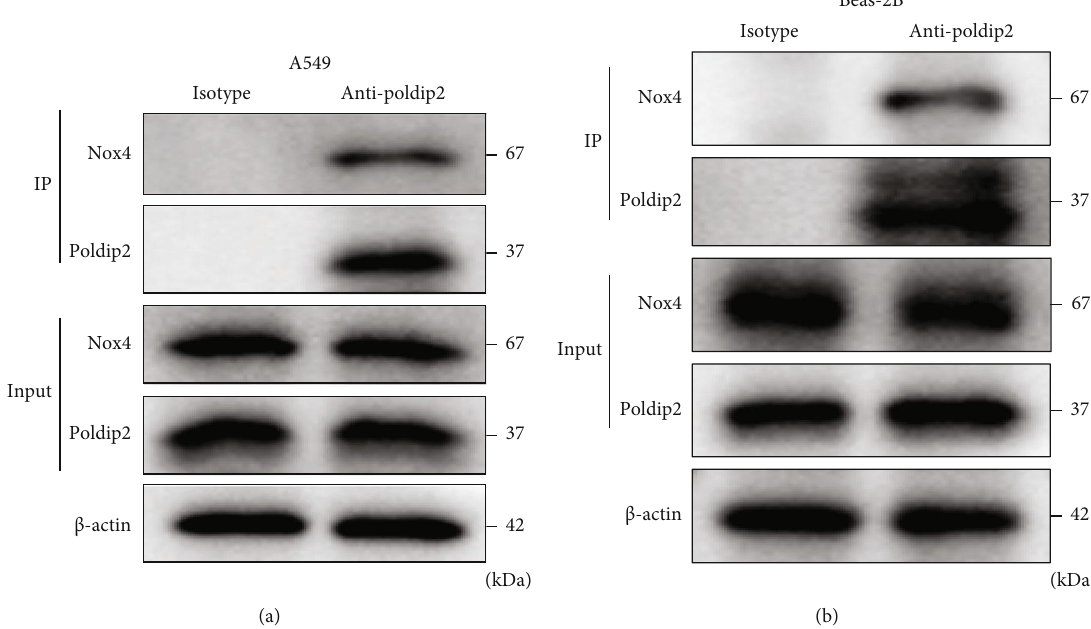
Figure 2: Poldip2 interacted with Nox4 induced by LPS with coimmunoprecipitation. (a, b) Con fl uent cells were treated with LPS (10 μ g/ mL for A549 cells and 1 μ g/mL for Beas-2B cells) for 12 h. Cell lysates were immunoprecipitated with normal rabbit IgG (isotype controls) or primary rabbit anti-Poldip2 antibody and immunoblotted with a mouse anti-Nox4 antibody or rabbit anti-Poldip2 antibody. Lysis bu ff er (Input) is a positive control in